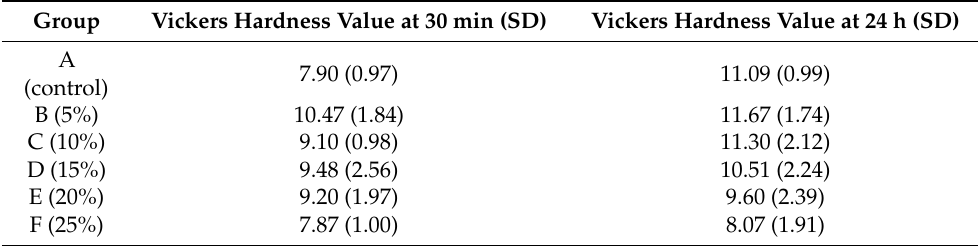
Figure 1. Vickers hardness for self-cure PMMA with various Gantrez concentrations ( n = 12). Note: means with letter “a” did not have a statistically significant difference ( p > 0.05) compared to their respective controls. Table 1. Vickers hardness for self-cure PMMA with various Gantrez concentrations ( n = 12). Group Vickers Hardness Value at 30 min (SD) Vickers Hardness Value at 24 h (SD)